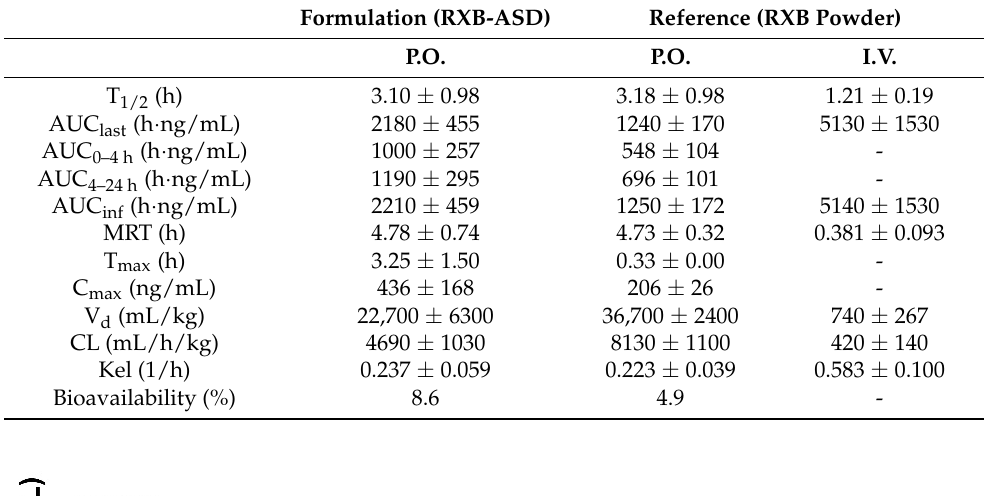
Table 6. Pharmacokinetic parameters of optimized RXB-ASD and raw RXB powder in rats after intravenous administration of 2 mg/kg and oral administration of 10 mg/kg. Data are shown as the mean ± SD ( n = 4).